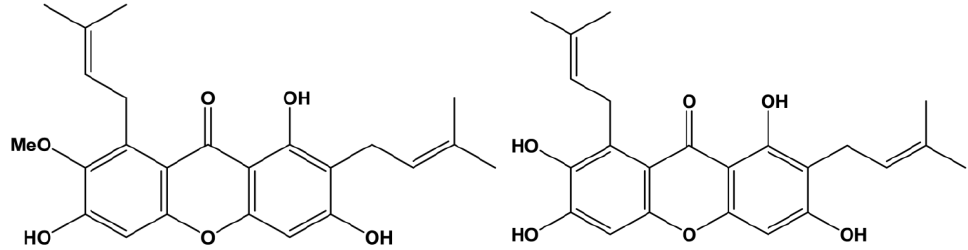
Figure 1. Chemical structures of two most abundant xanthones in mangosteen.